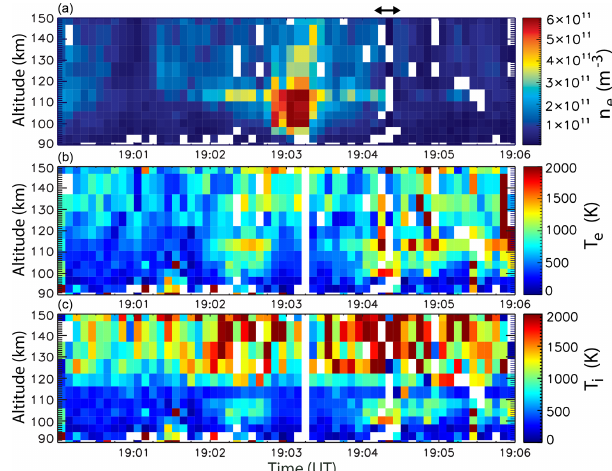
Figure 5. Electron density (a) , electron temperature (b) , and ion temperature (c) as a function of height and time estimated by ESR during event 1 on 4 December 2013. The time interval of the frag- ments is indicated by a double-headed arrow on top of panel (a) .